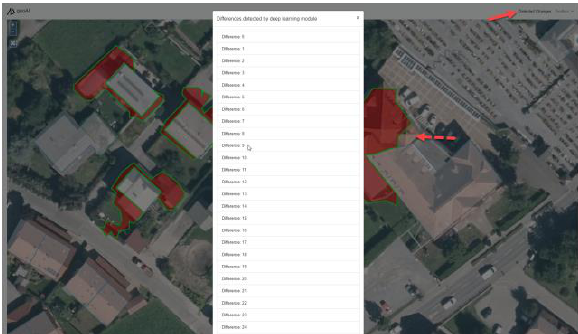
Figure 10. The list of detected change polygons returned by the DL method which also allows navigating to the locations.